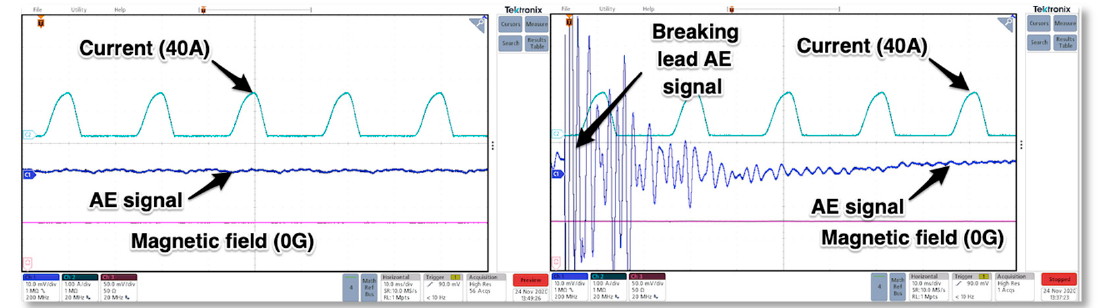
Figure 11. Waveforms of current, magnetic field and acoustic emission in regular GTO rectifying mode ( left ) and AE signal of break pencil lead test while GTO operating ( right ).